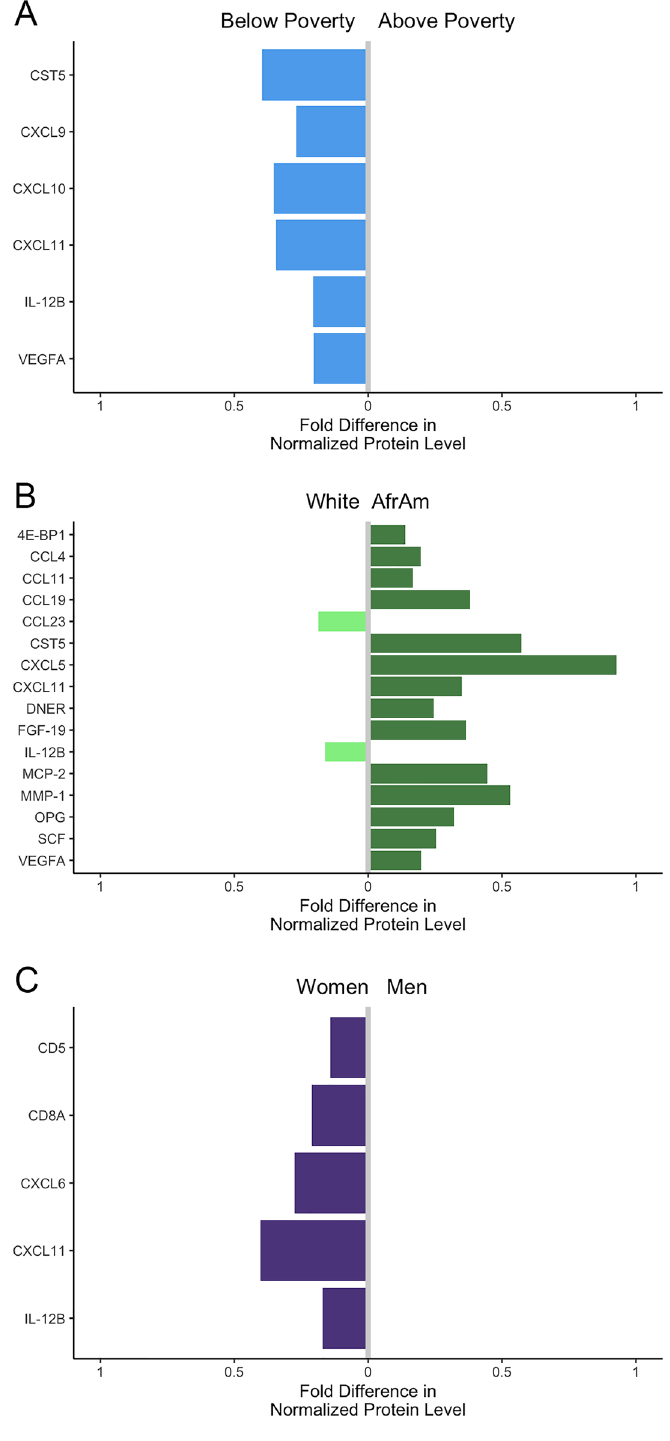
Figure 5. Plasma EV protein levels are altered with poverty status, race, and sex. Plasma EVs were isolated from 76 individuals deceased within 5 years along with 76 surviving individuals (Table 1). EVs were lysed and analyzed using a proximity extension assay. Mean differences in Normalized Protein Levels are shown in log 2 scale and are interpreted as fold differences. Proteins significantly associated with poverty status ( A ) race ( B ) and sex ( C ) were determined from linear regressions with all variables (sex, race, poverty status, mortality status) in the